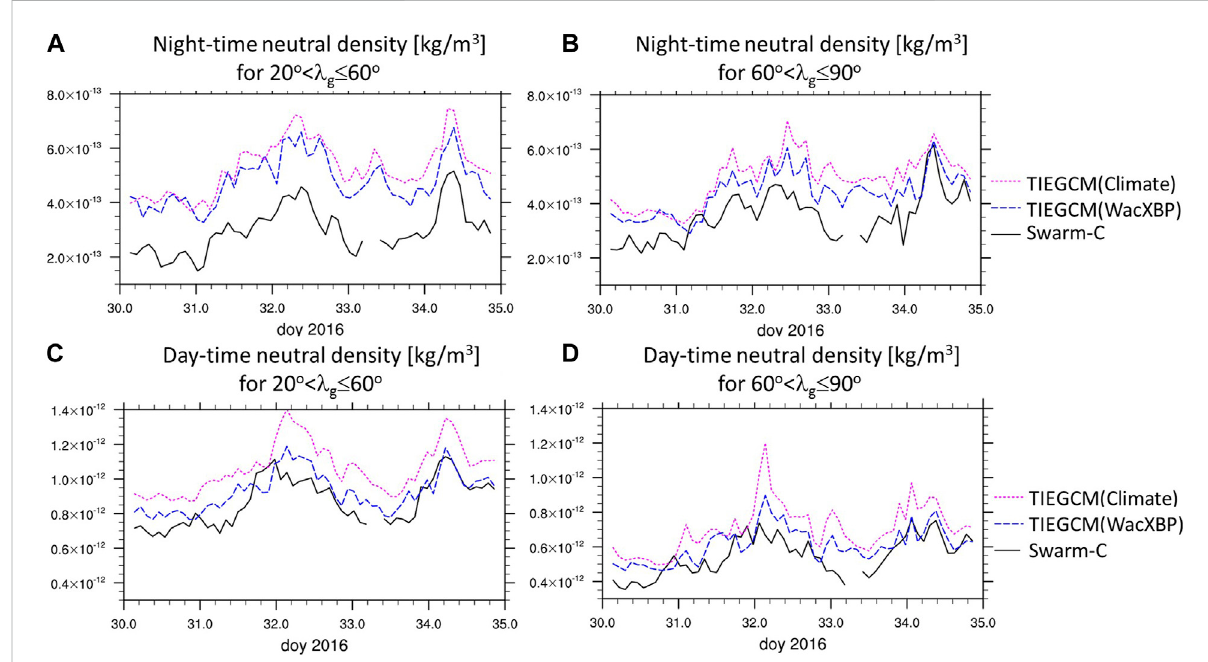
FIGURE 6 Northern hemisphere latitudinal average neutral density variations of Swarm-C (black solid lines), TIEGCM(WacXBP) (dark blue dashed lines), and TIEGCM(Climate) (magenta dotted lines) for night-time orbit (A – B) and day-time orbit (C – D) for 20 0 < λ g ≤ 60 0 (A) and (C) and for 60 0 < λ g ≤ 90 0 (B) and (D)